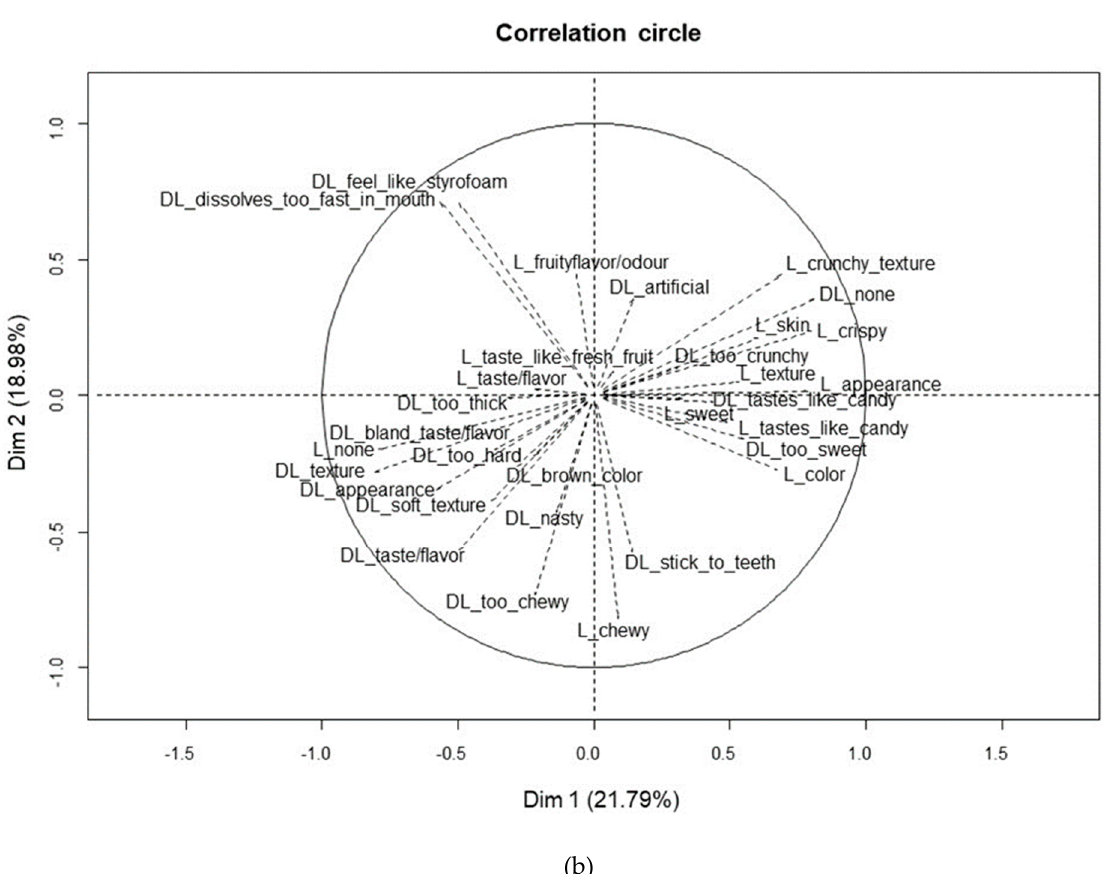
Figure 4. MFA plot of 13 dried fruit chips ( a ) and the reasons for liking and disliking them ( b ) among US